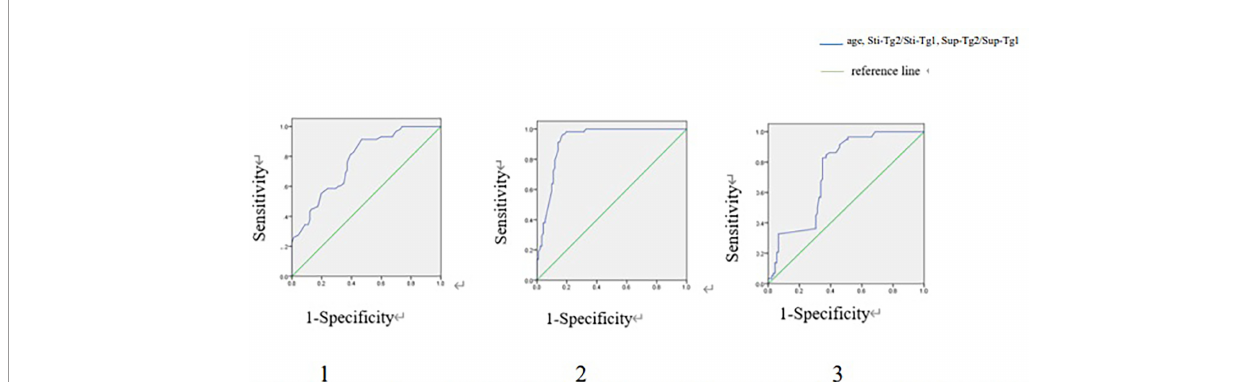
FIGURE 2 | ROC curves of age, Sti-Tg2/Sti-Tg1 and Sup-Tg2/Sup-Tg1 for detecting RAIR in TgAb negative group. ROC, Receiver operating characteristic; RAIR, radioactive iodine refractory. 1. ROC curve of age for detecting RAIR in TgAb negative group. Area under the ROC (AUC) curve 0.772 (95% CI:0.699-0.846),